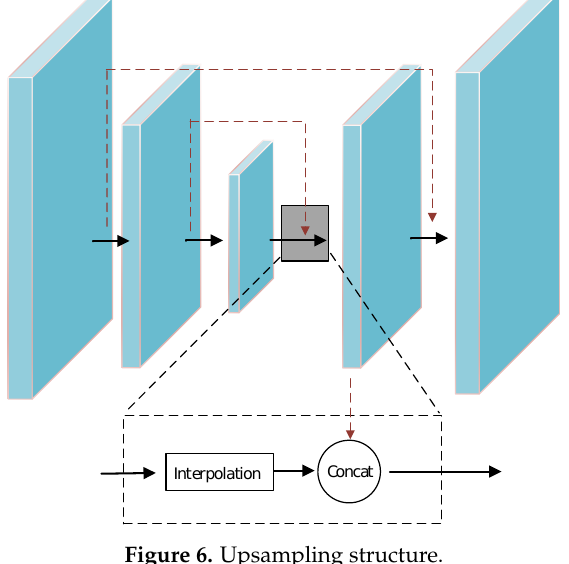
Figure 6. Upsampling